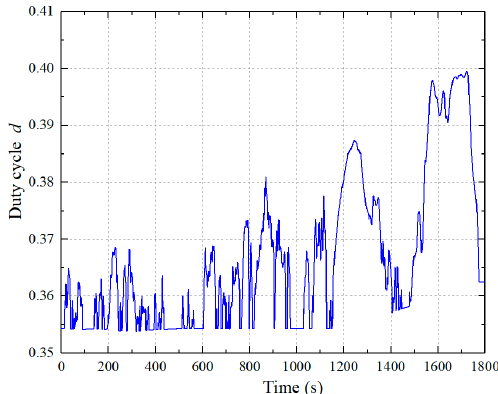
Figure 13. The duty cycle variation curve.